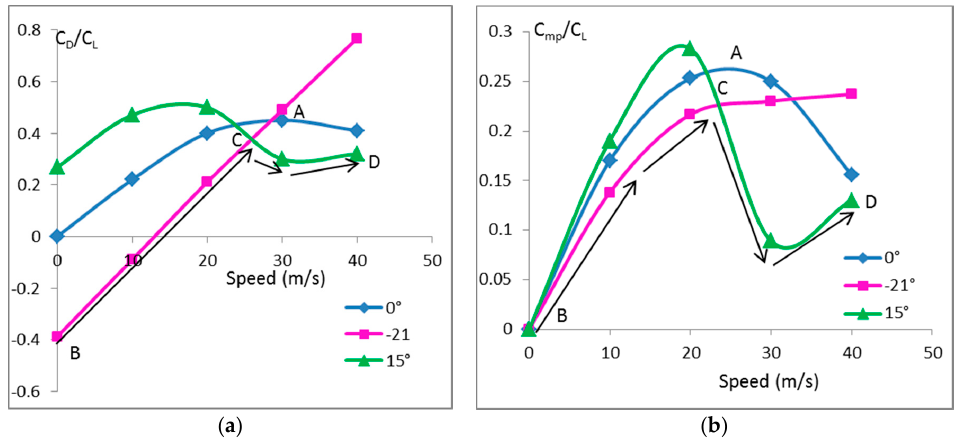
Figure 11. Computed time-averaged drag and pitching moment coefficient to lift coefficient ratio at different angles of attack in transition mode. The arrows indicate the recommended strategy to increase drag and pitching moment in transition. ( a ) Drag to lift ratio; ( b ) Pitching moment to lift ratio.